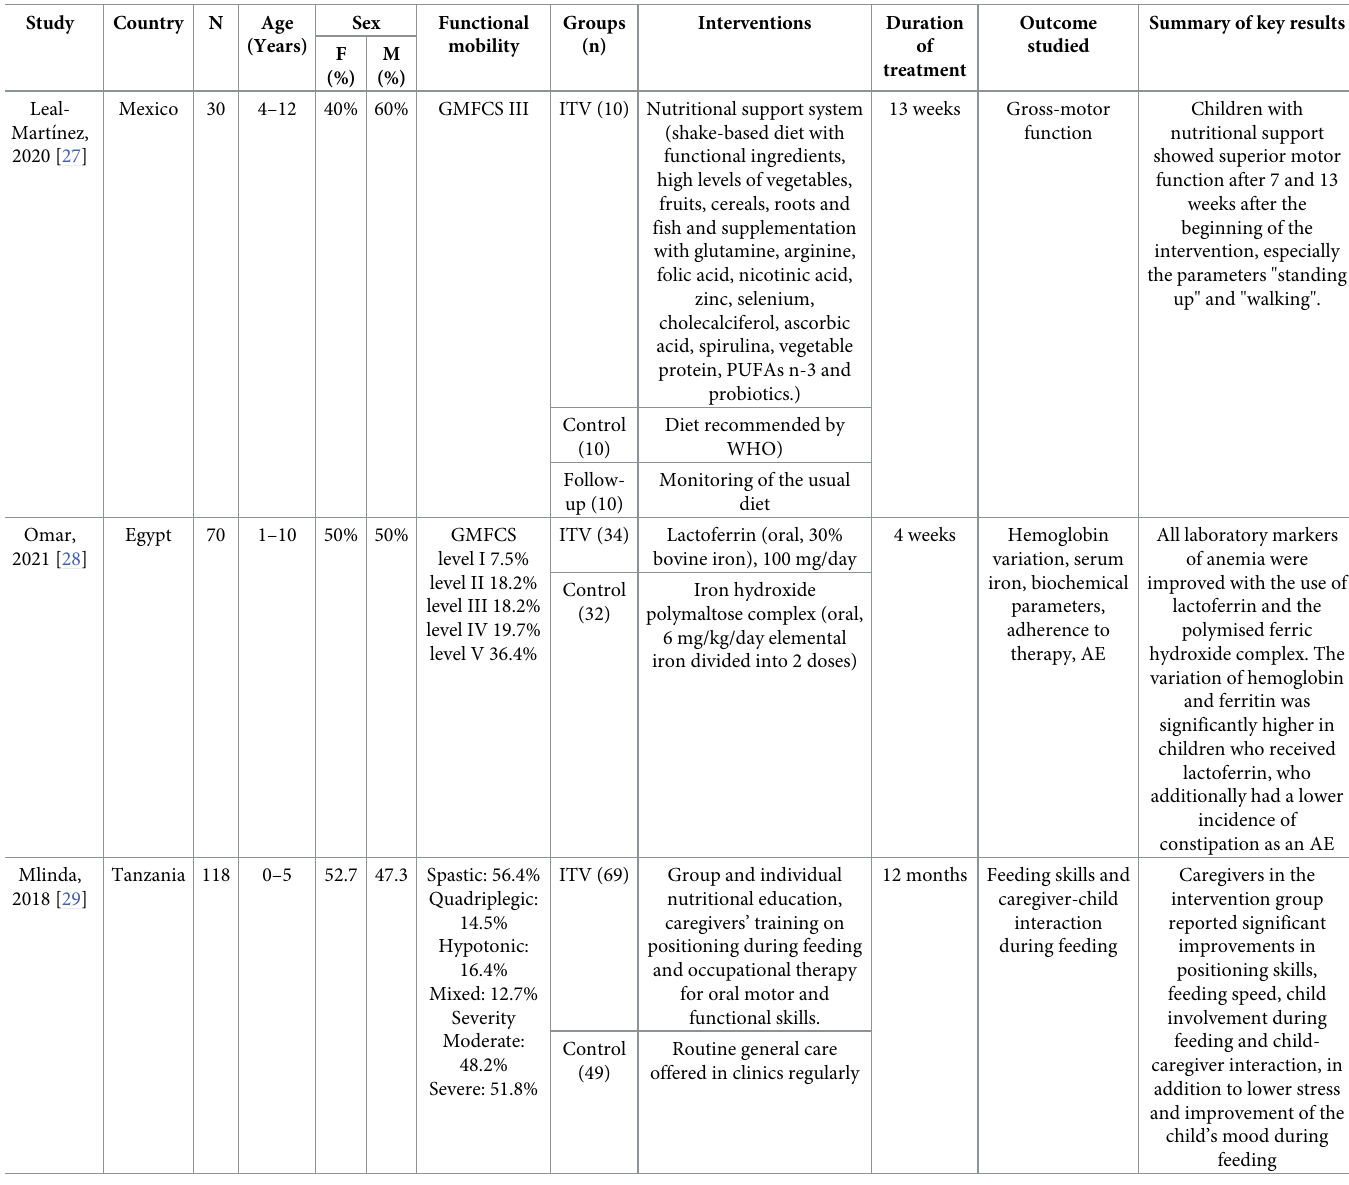
Table 5. Characteristics of the studies evaluating others main outcomes as follows: Motor function, laboratory markers of anemia and feeding